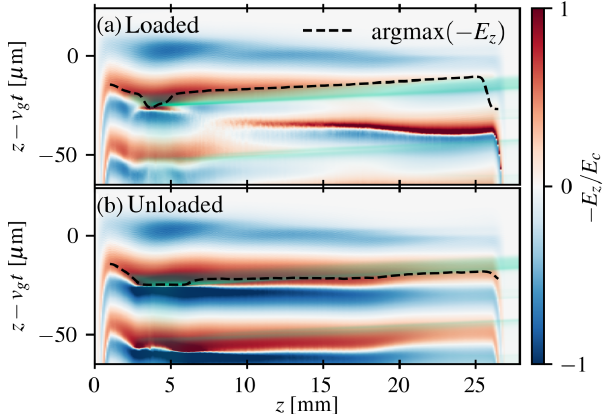
FIG. 4. (a) Loaded and (b) unloaded longitudinal electric field and injected electron bunch position (green) over the propagation ¼ 1 . 25 × 10 18 cm − 3 . The axis z of PIC simulations with n e unloaded fields were extracted from a simulation without the ionization injection species. The maximum accelerating field position in the first plasma period (black line) is